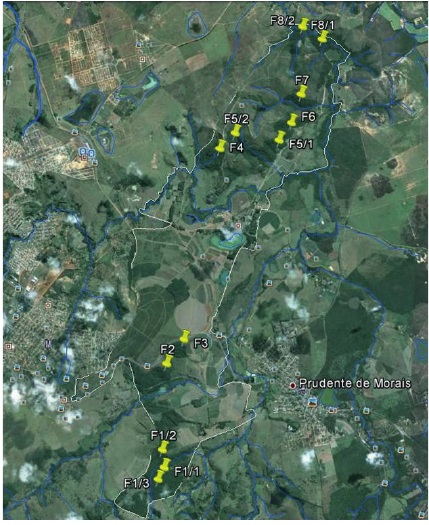
Figure 1: Location of the study sites in each fragment of the Embrapa Experimental Farm, Sete Lagoas, MG,